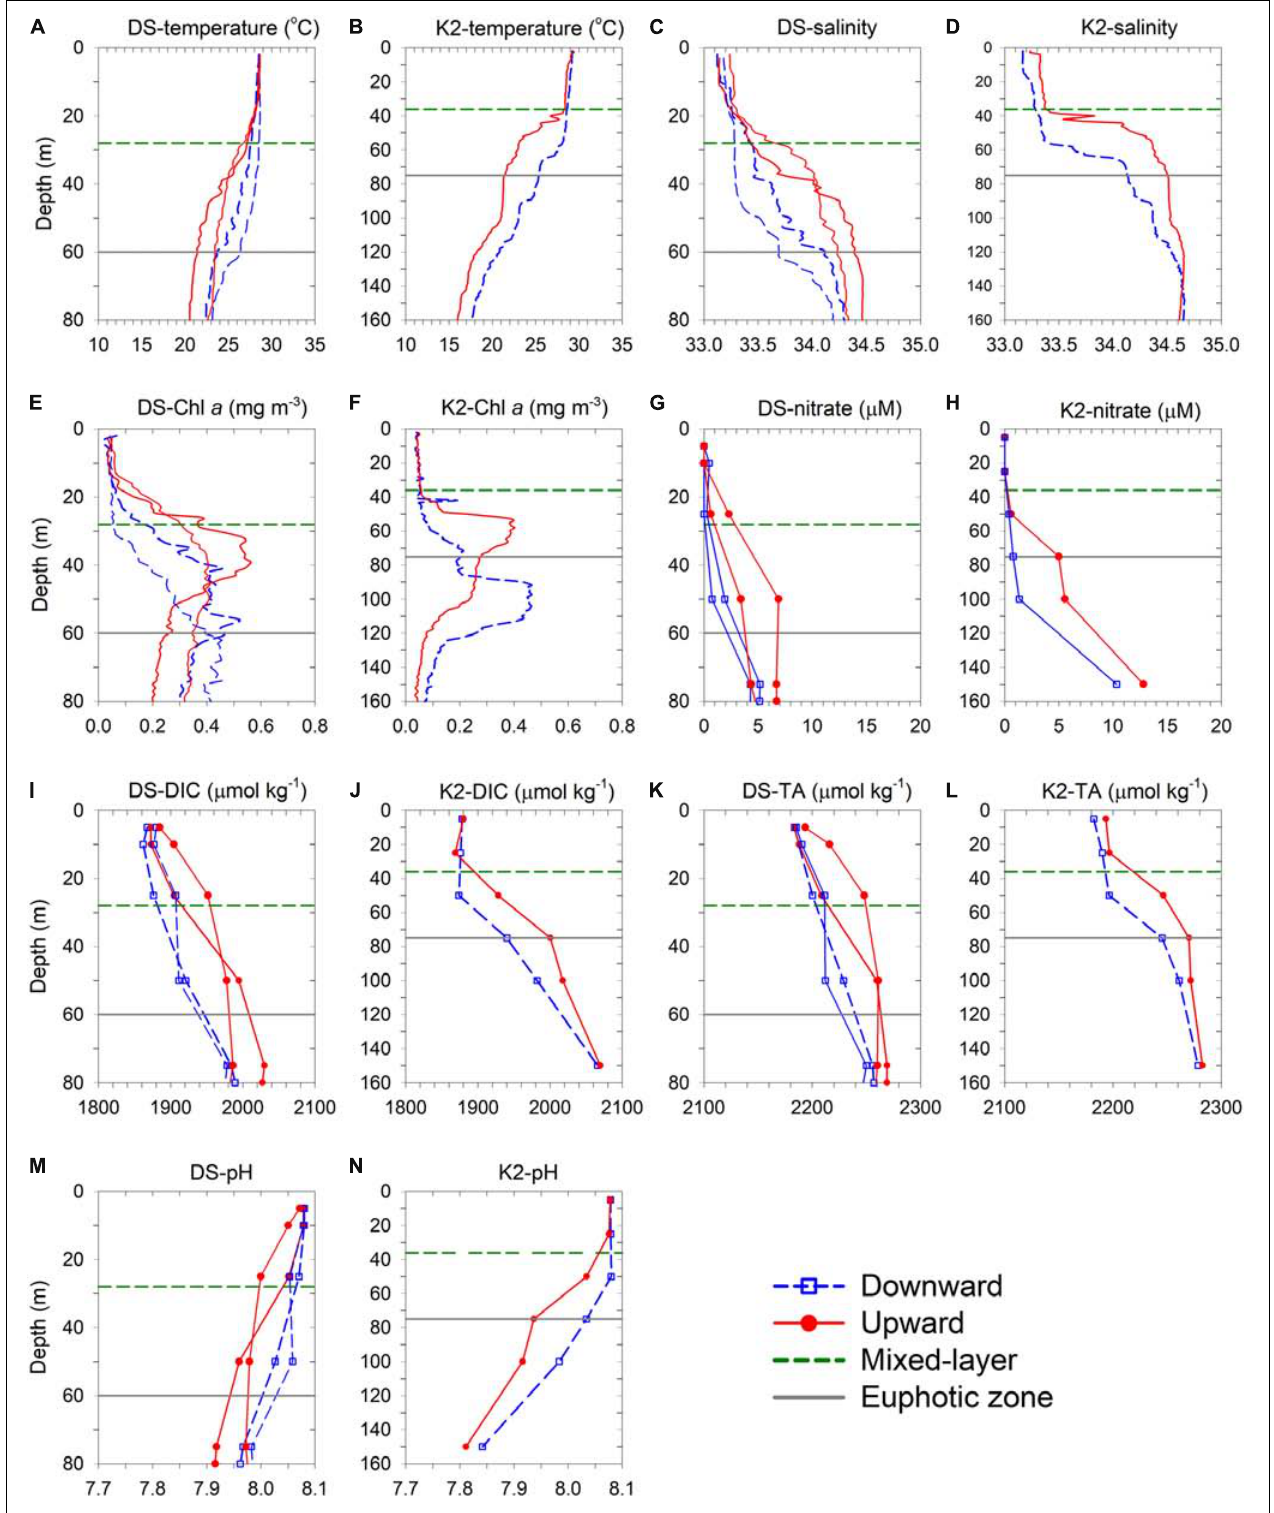
FIGURE 3 | Depth distributions of temperature (A,B) , salinity (C,D) , Chl a (E,F) , nitrate (G,H) , DIC (I,J) , TA (K,L) , and pH (M,N) during the upward (solid line) and downward (dashed line) phases of the isotherm displacements at the DS and K2 stations. The horizontal dashed and solid lines represent the average depths of mixed-layer and euphotic zone, respectively. SCMD, subsurface Chl a maximum depth.